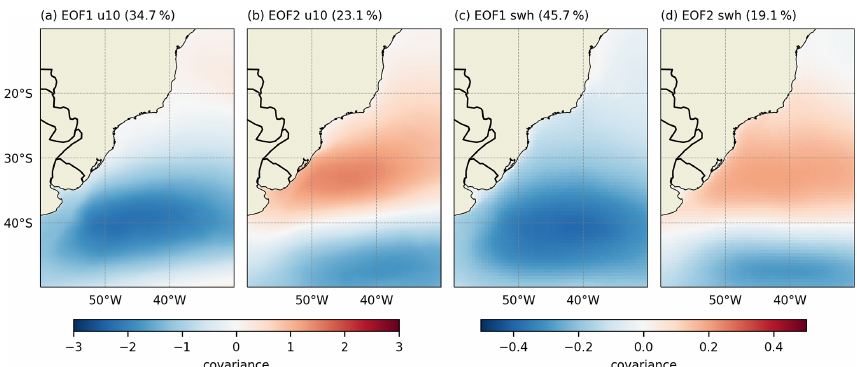
Figure 2. EOFs of filtered anomalies of (a, b) 10m zonal wind ( u 10 ) and (c, d) significant wave height (swh) calculated on the wSA. The percentages represent the explained variance of each mode.